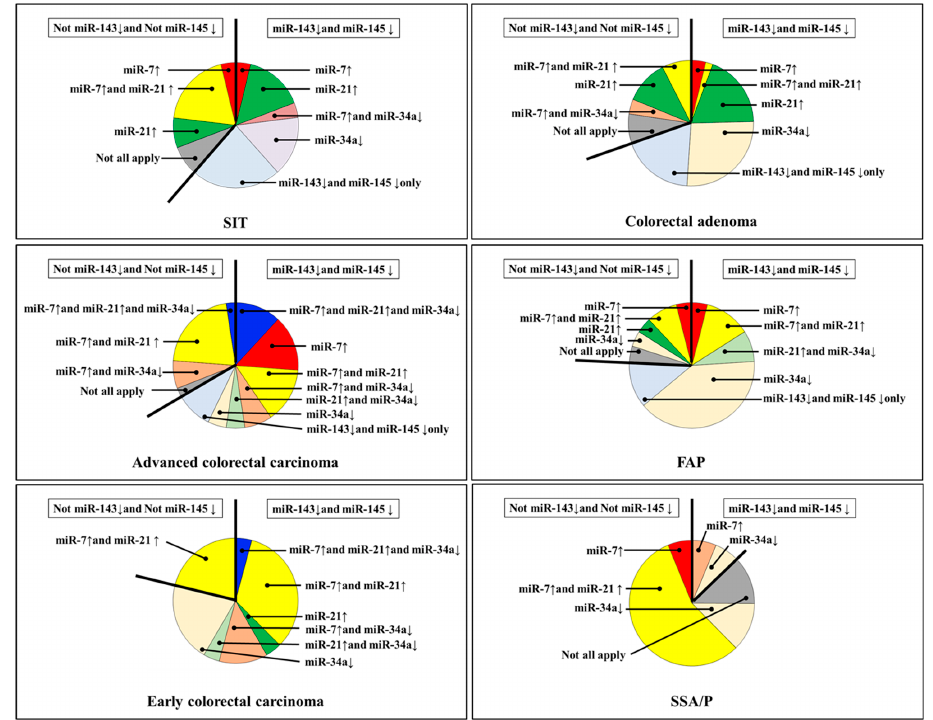
Figure 2. Expression profiles of miR-7, miR-34a, and miR-21 with or without downregulation of miR-143 and miR-145 in human colorectal tumors. ↓ , downregulated; ↑ , upregulated; SIT, small intestinal tumor (adenoma and adenocarcinoma); FAP, familial adenomatous polyposis; SSA/P, sessile serrated adenoma/polyp.